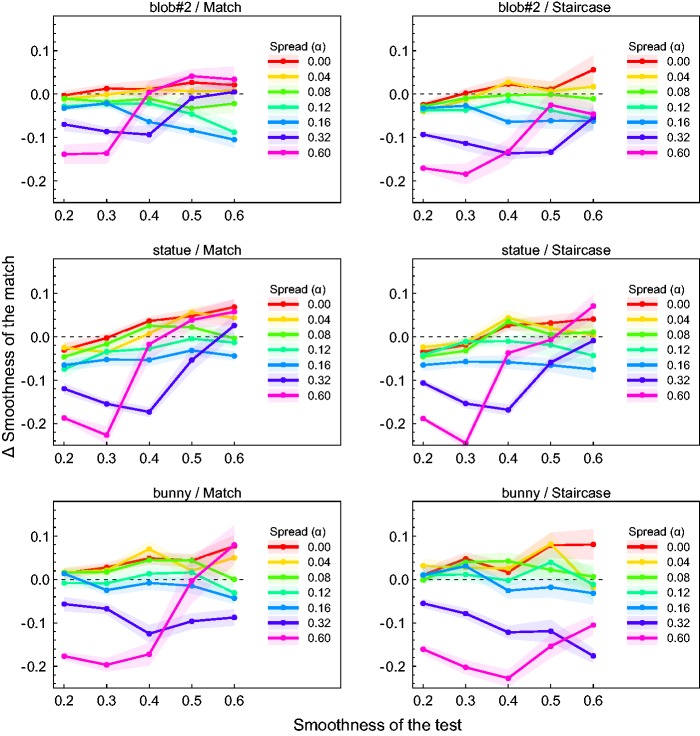
Results of the preexperiment, averaged across all three subjects. The diagrams
are ordered by shape condition (rows) and the psychophysical method (columns). The
original smoothness settings were transformed into the measure Δ smoothness. The
mean Δ smoothness values are plotted against the smoothness of the test, with
light spread as grouping variable (colored lines). Transparent areas around each
curve represent ±SEM.